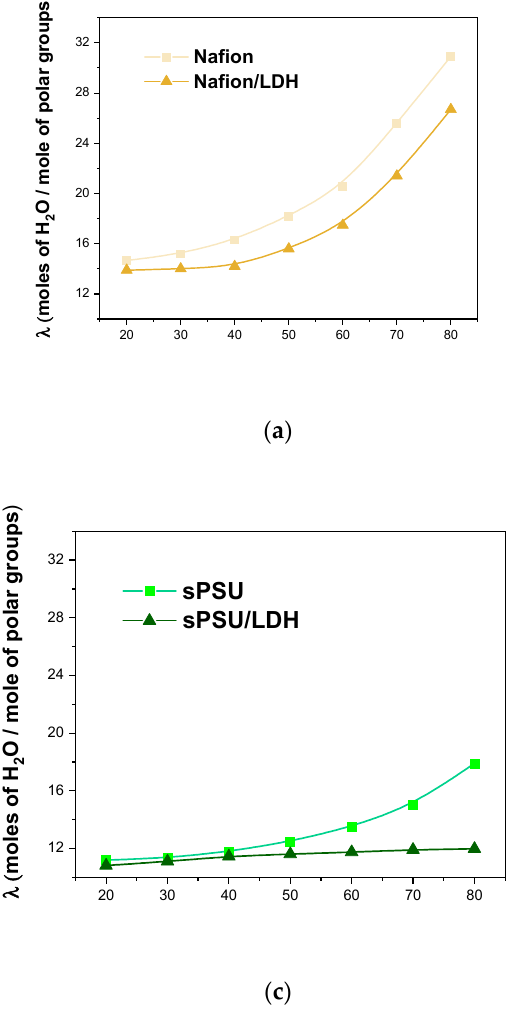
Figure 5. Temperature evolution of λ for ( a ) Nafion-based, ( b ) sPEEK-based, and ( c ) sPSU-based membranes.